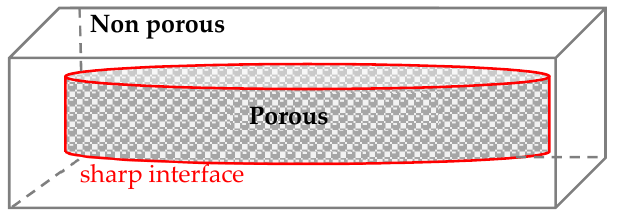
Figure 4. Scheme of a bulk sample of PMMA/20 wt% additive (D200, D480, Dlab or MAM) foamed following Set II.